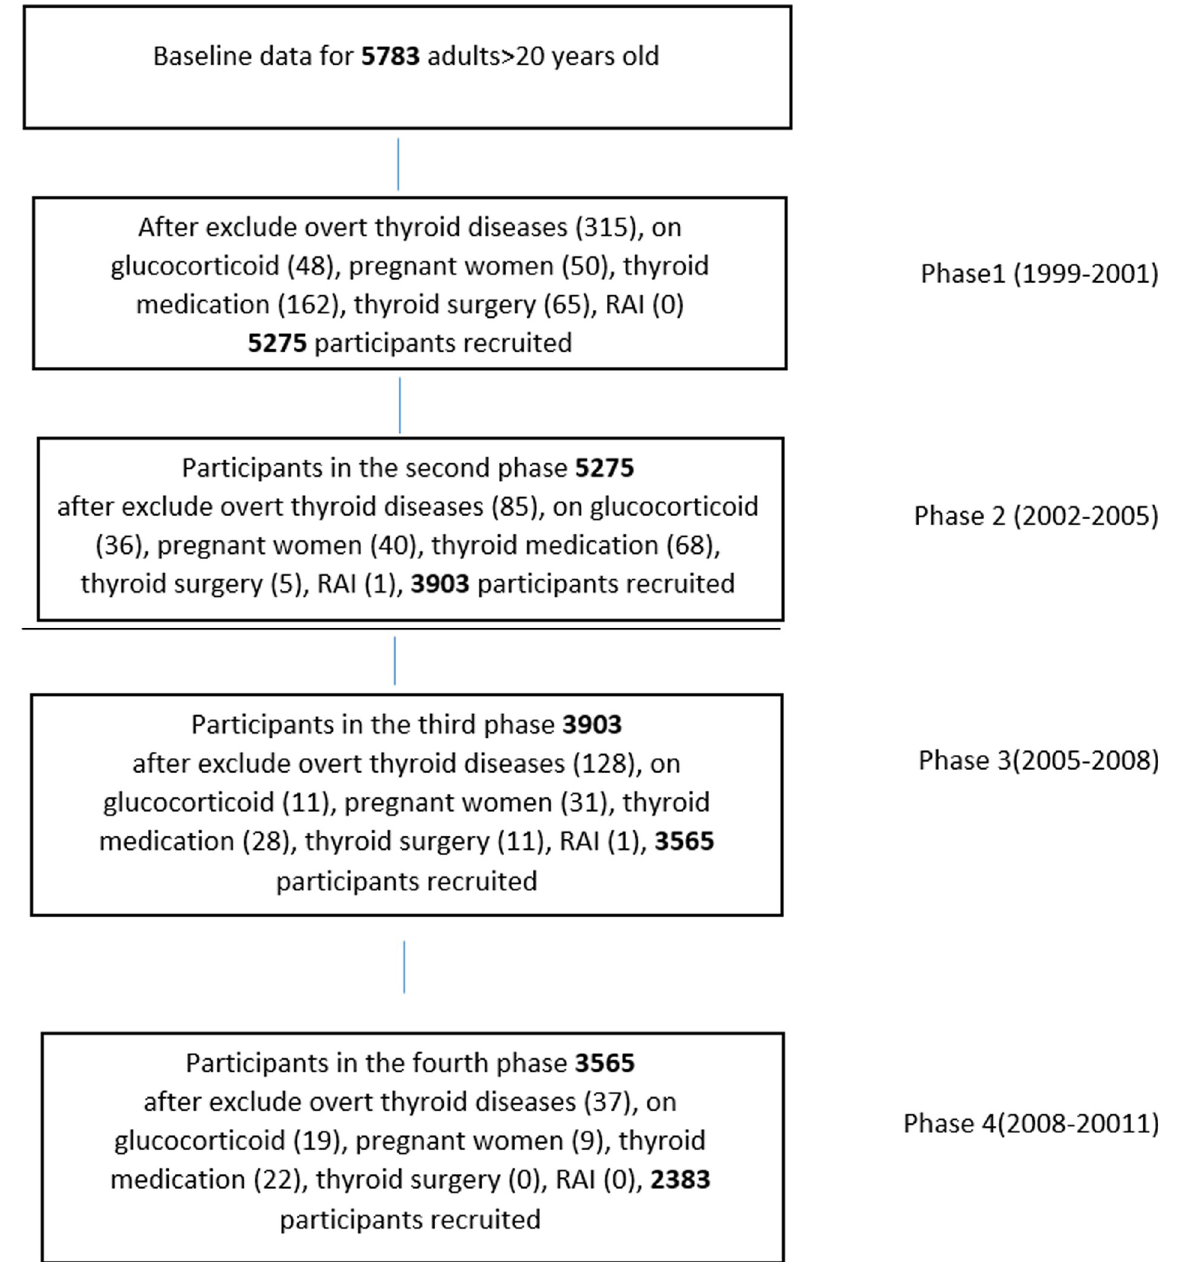
Fig 1. Study population. using Roche Diagnostics kits and Roche/Hitachi Cobas e- 411 analyzer (GmbH, Mannheim, Germany). To monitor the accuracy of assays lyophilized quality control material (Lyphochek Immunoassay plus Control, Bio-Rad Laboratories) was used. Intra- and inter-assay CVs were 1.3% and 3.7% for FT4 and 1.5% and 4.5% for TSH determinations, respectively. Immunoen- zymometric assay (IEMA) by the related kit (Monobind, Costa Mesa, CA, USA) and the Sun- rise ELISA reader (Tecan Co., Salzburg, Austria) were used for thyroid peroxidase antibody